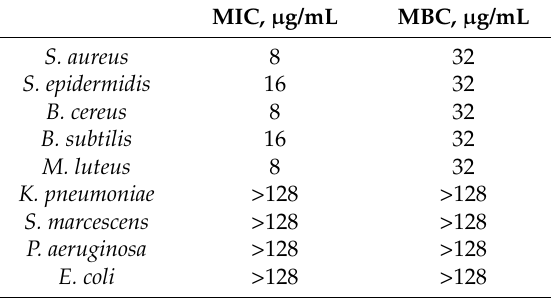
Table 1. Antimicrobial spectrum of F105 .